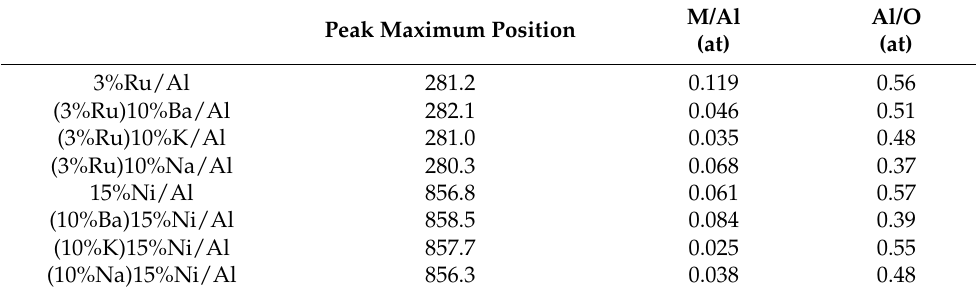
Table 1. XPS data of reduced catalyst previously to reaction. Peak Maximum